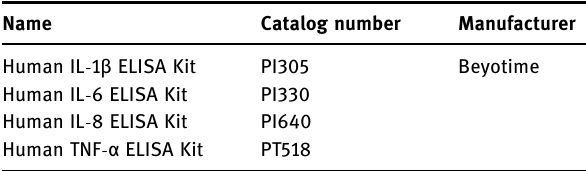
Table 4: The information of ELISA